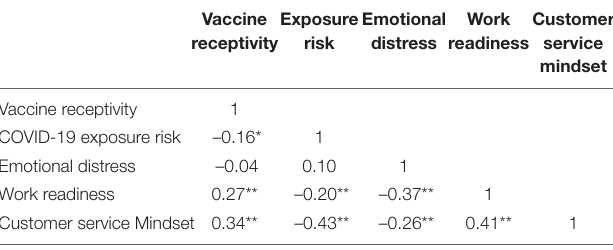
TABLE 7 | Relations between vaccine receptivity and other variables (Study